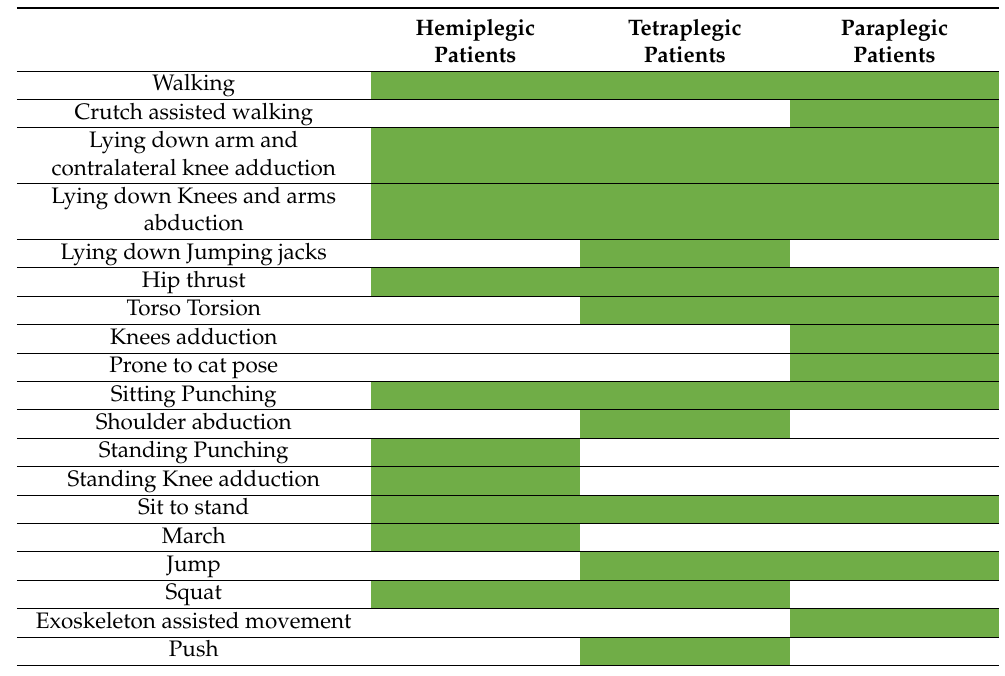
Table 4. List of exercises performed by the patients’ groups. The green coloured squares indicate which exercises were registered for each group. Healthy controls performed all the exercises to match with patients’